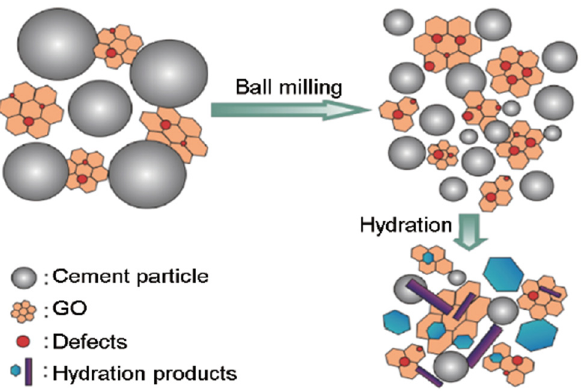
Figure 7: E ff ect of GONSs contents on the fl uidity of cement mortars [ 61 ] .